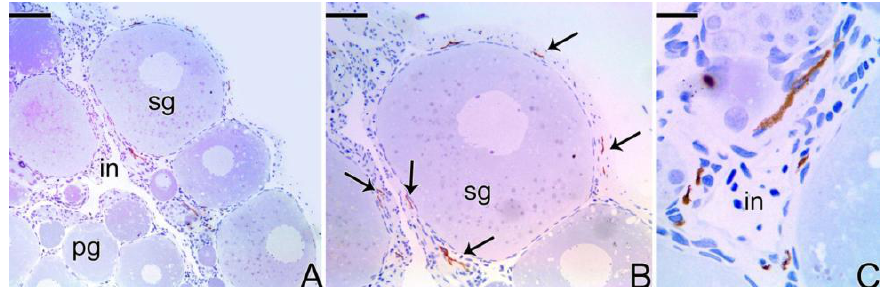
Figure 8. Immunohistochemistry for detection of MMP-9 metalloproteinase in ovary of S. marmoratus . Note the positive labeling in the interstitial cells (arrow). Primary growth oocyte (pg), secondary growth oocyte (sg), interstitium (in). Counterstaining: Harrys Hematoxylin. Bar: 80μm ( A ), 30μm ( B ), 15μm ( C ).